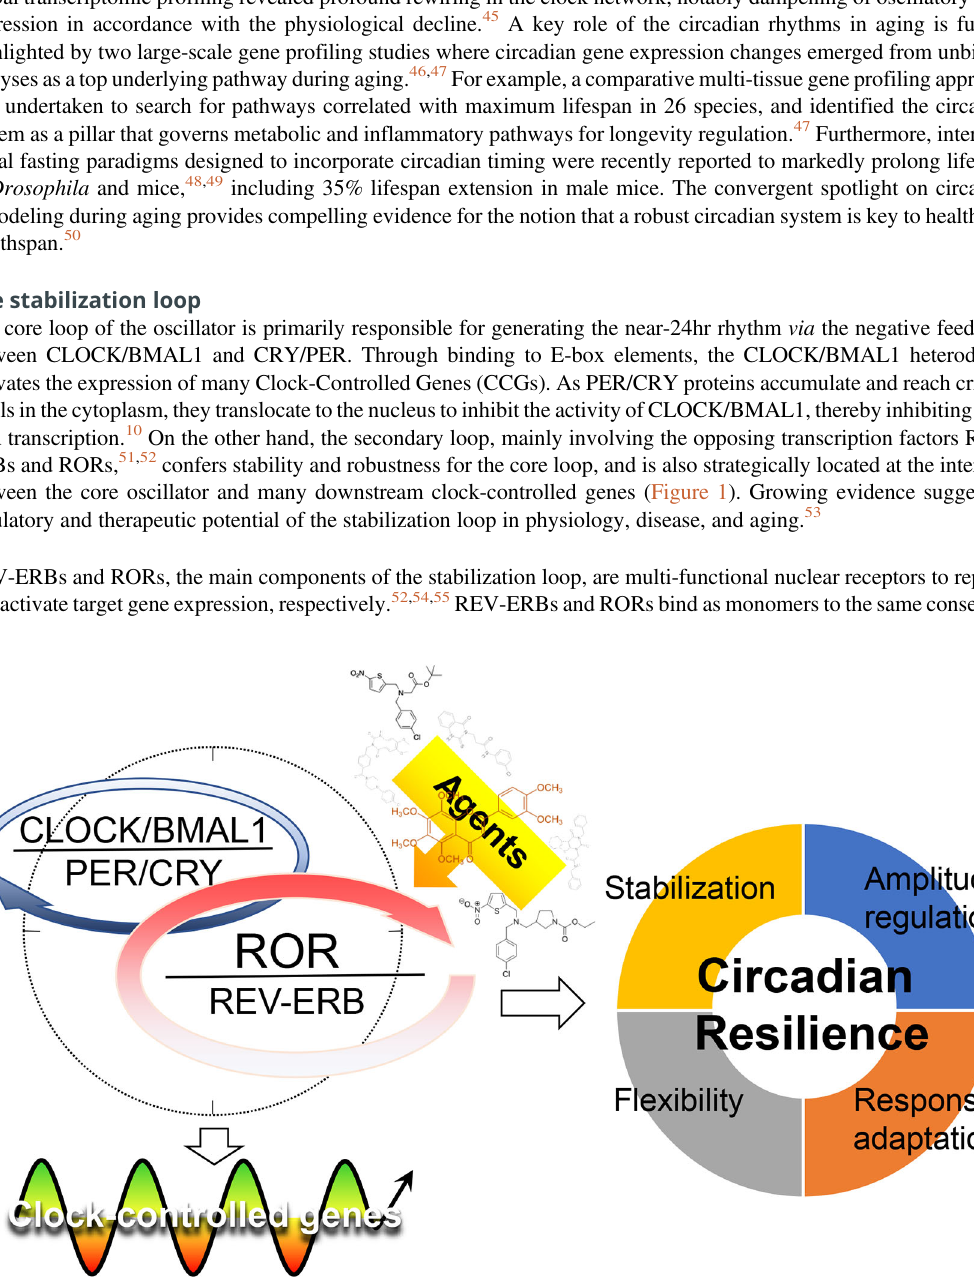
Figure 1. The stabilization loop of the circadian oscillator is strategically situated at the interface of the rhythm-generating core loop and the circadian output network. The core oscillator mainly consists of core and stabilizationloopsasindicatedbythedottedcircle.TheREV-ERBandretinoicacidreceptor-related orphanreceptors (RORs) compete at the consensus ROR response elements (ROREs) of target gene promoters, including basic helix- loop-helixARNTlike1( Bmal1 )andmanyclock-controlledgenes(CCGs),toregulatecircadiantranscriptioninatissue- specific manner. They may interact via other mechanisms and in clock-independent processes – see text for